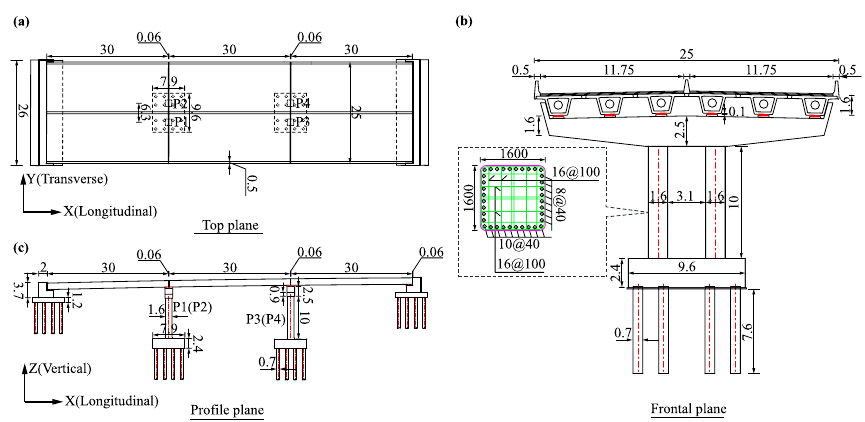
Fig. 1 General configuration of the prototype bridge (unit: m): a top plane, b frontal plane and c profile